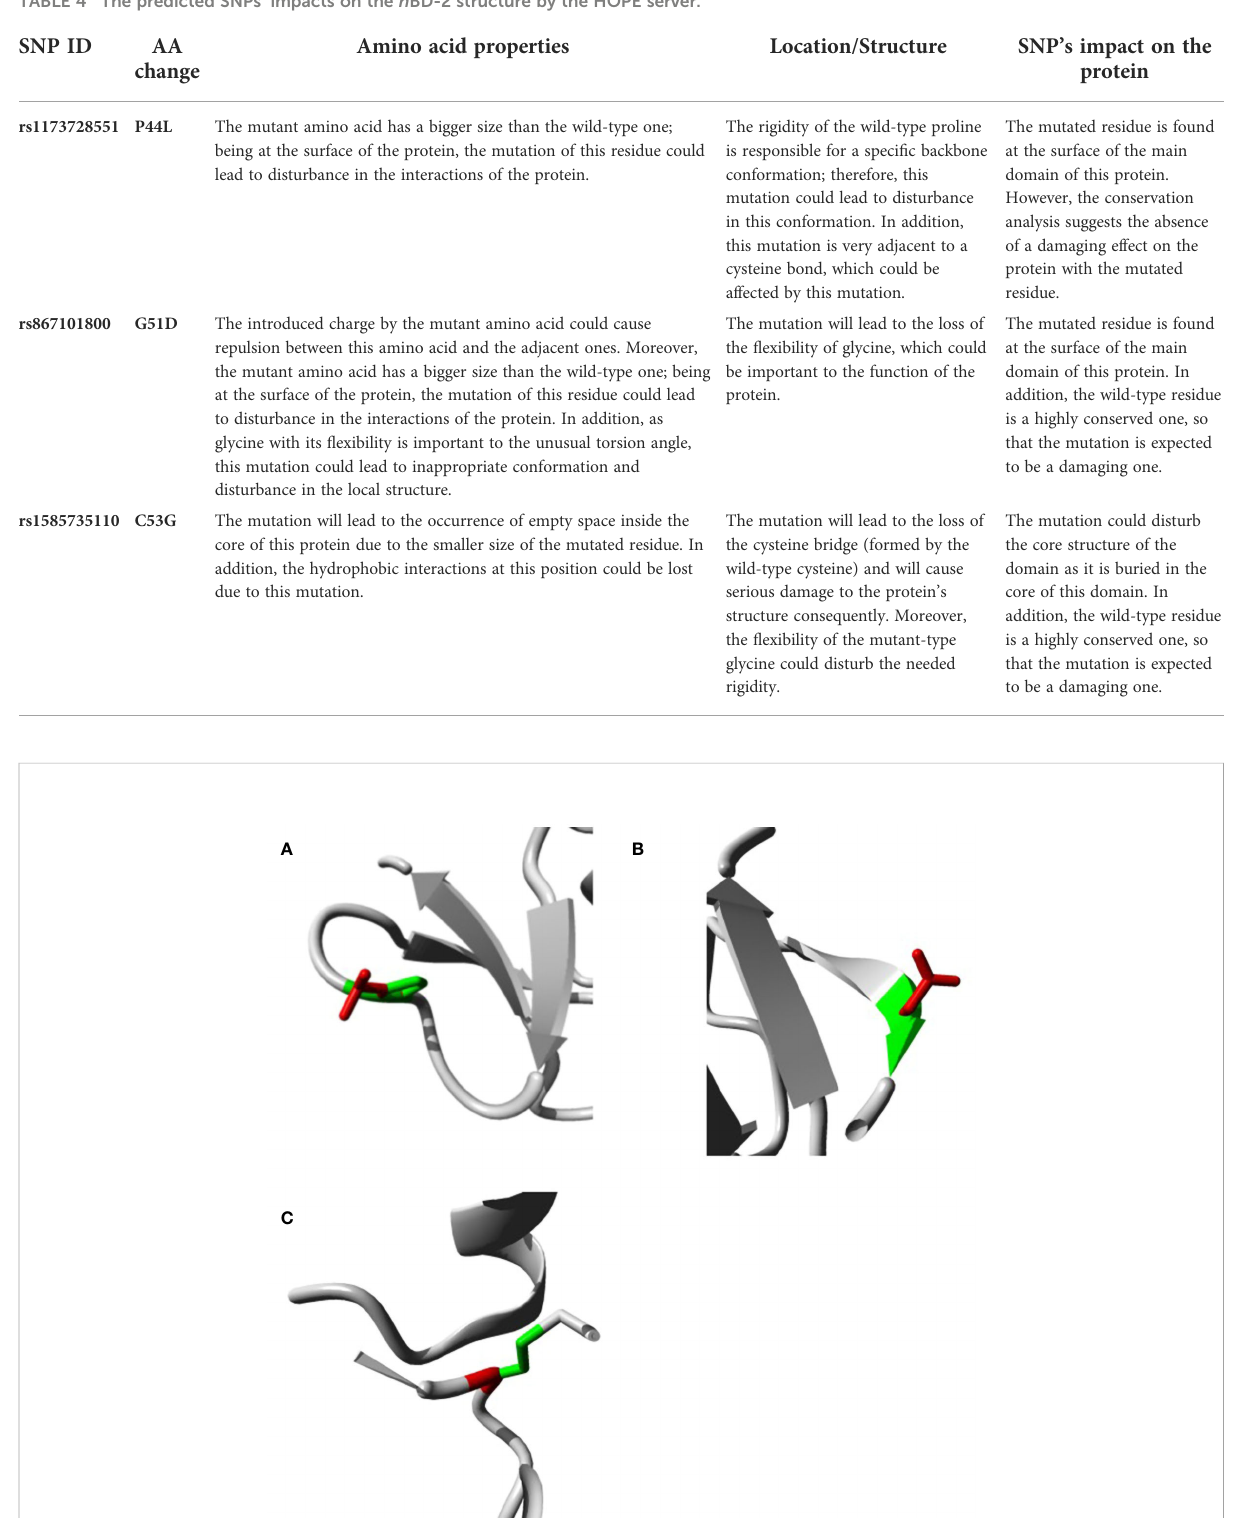
TABLE 4 The predicted SNPs ’ impacts on the h BD-2 structure by the HOPE